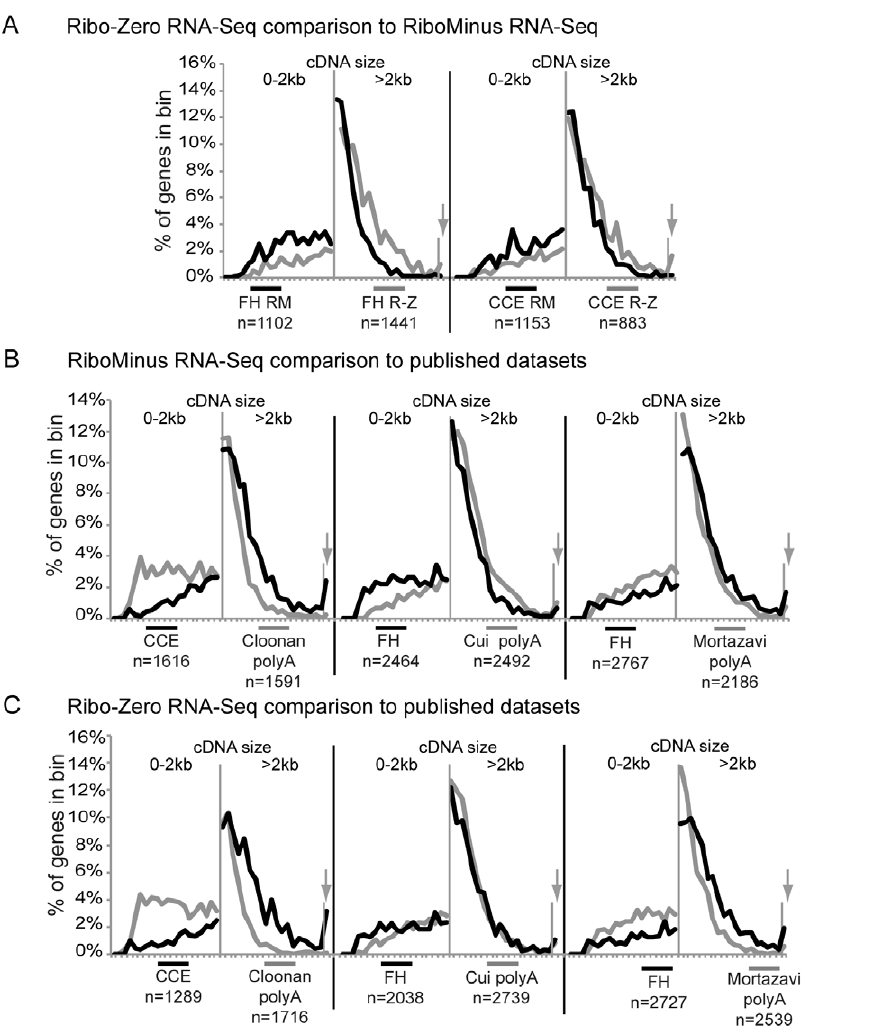
Figure 6. The template preparation protocol determines the comparability of ribo-depleted RNA-Seq to polyA RNA-Seq. The cDNA size distribution of genes showing more than 8 6 expression difference (Figure S2), in the comparison of ( A ) FH RiboMinus - FH-RiboZero (left) and CCE RiboMinus - CCE Ribo-Zero (right). ( B ) as in A for the comparisons of CCE RiboMinus-Cloonan et al. EB (left), FH RiboMinus-Cui et al. adult mouse brain polyA (middle) and FH RiboMinus-Mortazavi et al. adult mouse brain polyA (right). ( C ) as in A for the comparisons of CCE Ribo-Zero-Cloonan et al. EB (left), FH Ribo-Zero-Cui et al. adult mouse brain polyA (middle) and FH Ribo-Zero-Mortazavi et al. adult mouse brain polyA (right). For Cloonan et al. EB both the gene expression data from the published alignment (shown in B, C, see Materials and methods) and from an alignment done with the pipeline used here (data not shown) were used and produced the same highly significant differences. Two different size classes are shown with different bin sizes (0–2 kb, 100 bp bins and . 2 kb, 500 bp bins). Genes bigger than 11.5 kb are grouped in the last bin